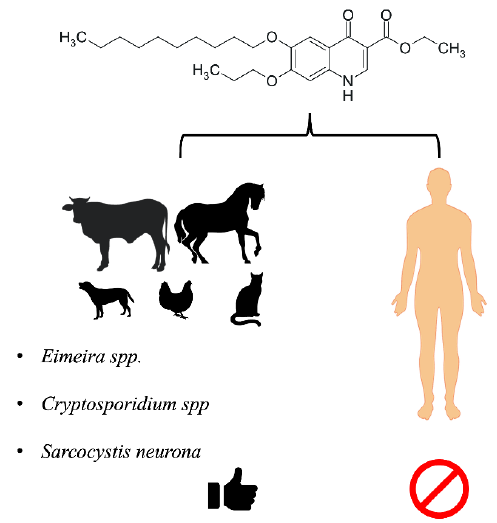
Figure 1. Overview of the clinical use of DQ against parasitic infections.